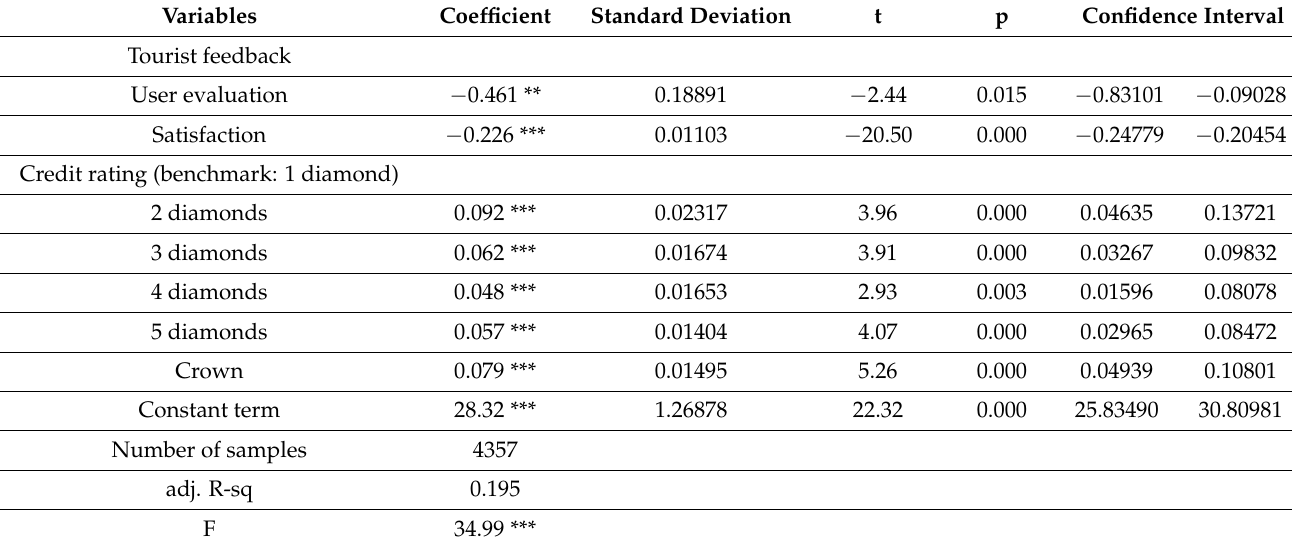
The results of regression: the impact of extended product characteristics of online itineraries on purchasing